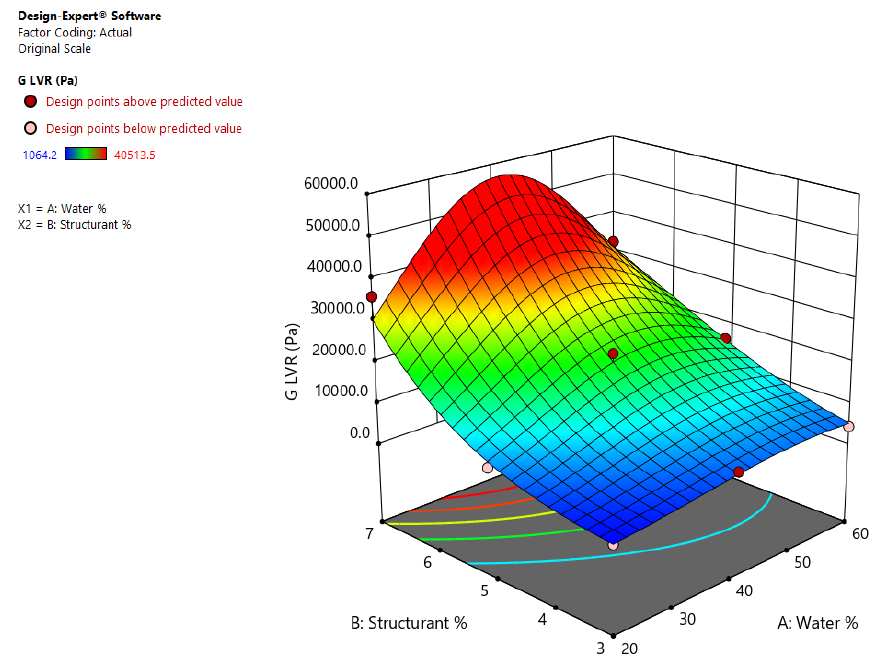
Figure 3. Effects of wax and water concentration on the determined G’ LVR of shellac wax oleogel emulsions.